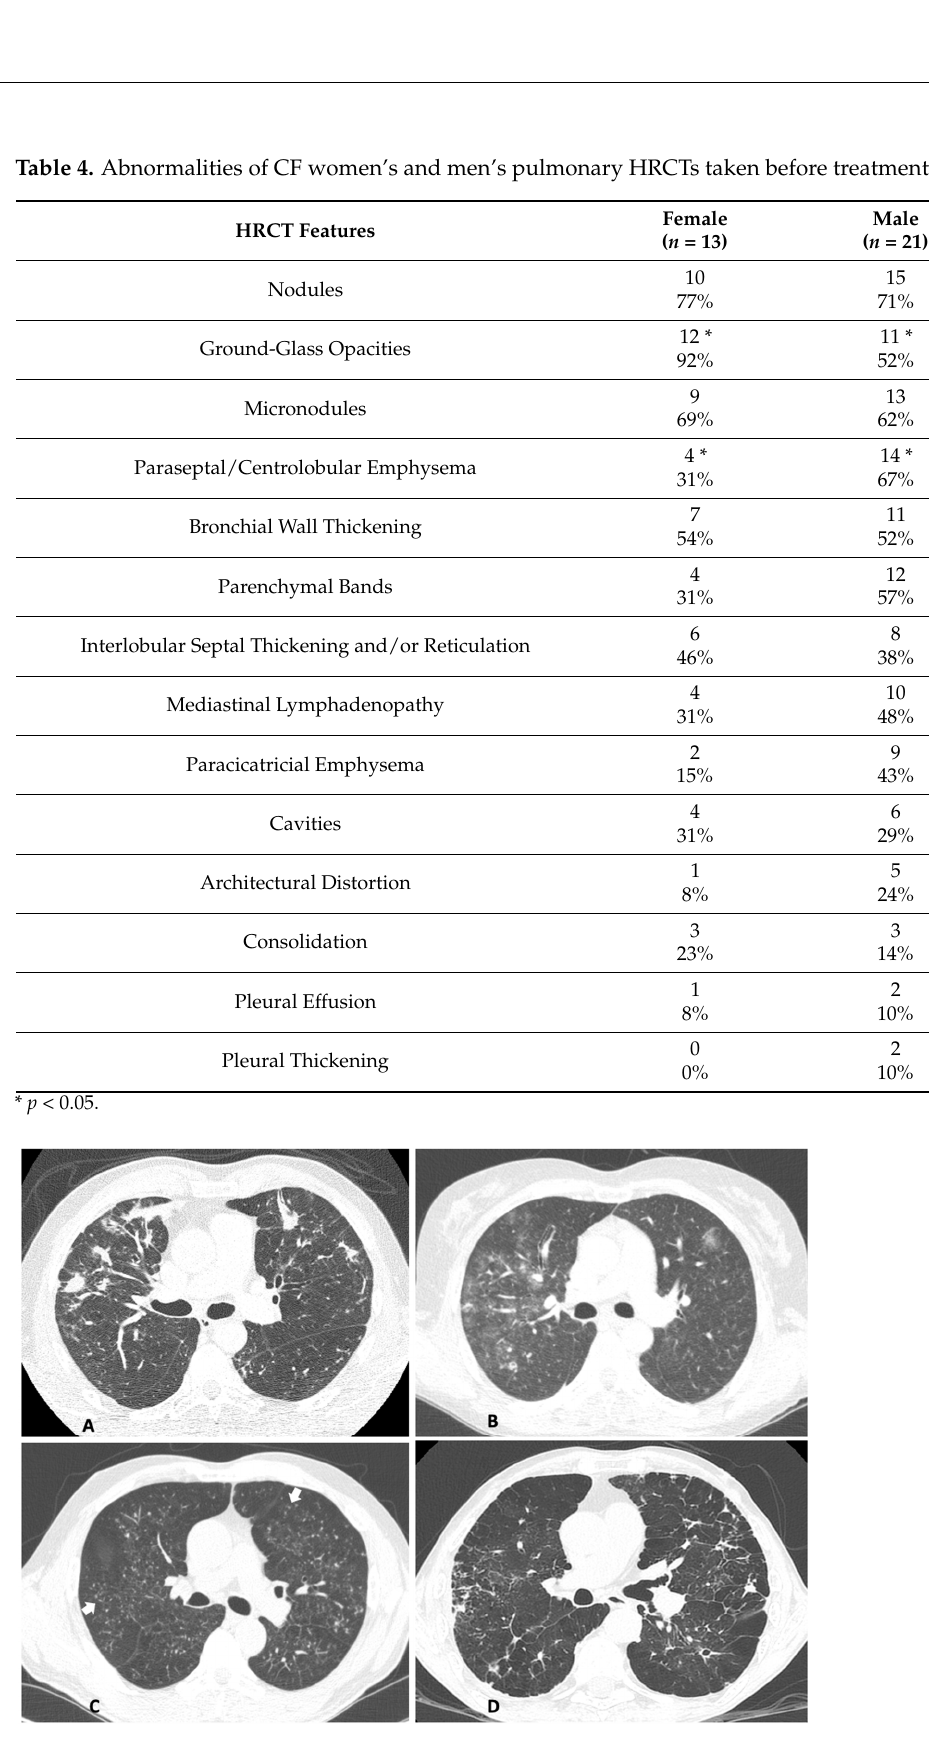
Figure 2. The most common alterations found on women’s pulmonary HRCT taken before treatment. ( A ) Upper lobes showing nodules. ( B ) Upper lobes showing ground-glass opacities. ( C ) Lower lobes showing micronodules (some indicated by arrows). ( D ) Diffuse emphysema and architectural distortion.